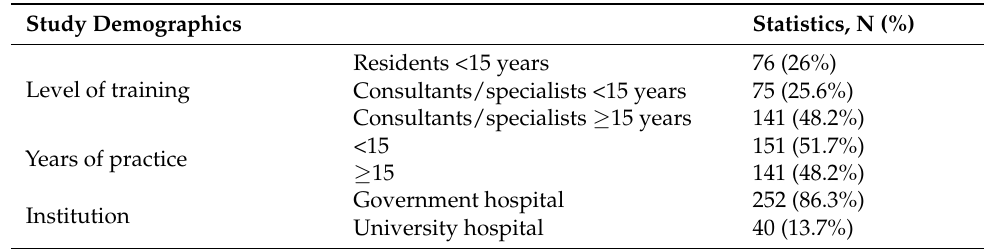
Table 2. Demographic characteristics of the